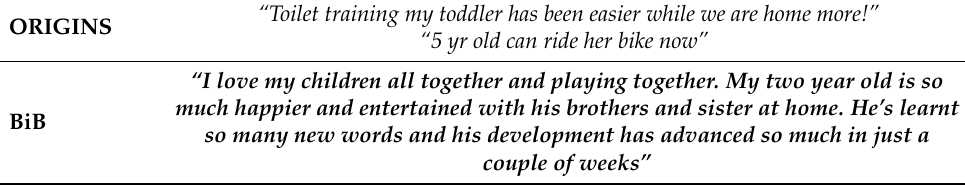
Table 8. Positive impacts: Sample responses.